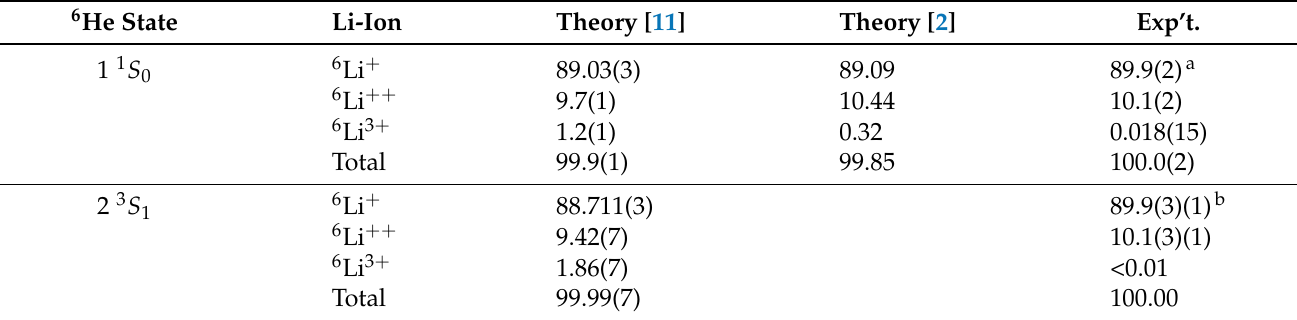
Table 1. Comparison of the previous theory with experiments for the probabilities p( 6 Li k + ) of forming the various charge states with k = 1,2,3 following the beta decay of 6 He(1 1 S 0 ) or 6 He(2 3 S 1 ) as the initial states. All quantities are expressed in percent